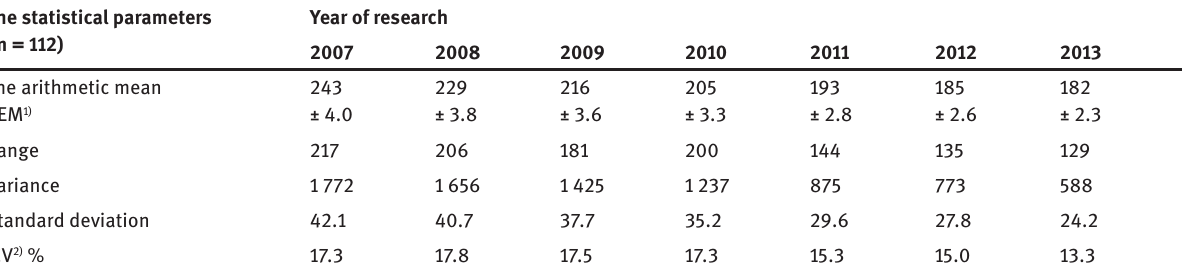
Figure 4: Map of the K content according to the individual classes of fertility in Charbielin (heavy soils) and Przeworno (light soils) at the beginning (2007) and at the end of the experiment (2013). Table 5: The impact of variable fertilization on changes in the content of the available form of potassium (mg kg -1 soil) in the heavy soil –